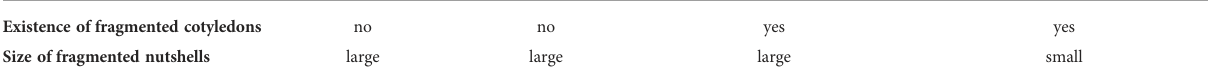
TABLE 2 Identi fi cation of different processing methods based on fragmented residue.